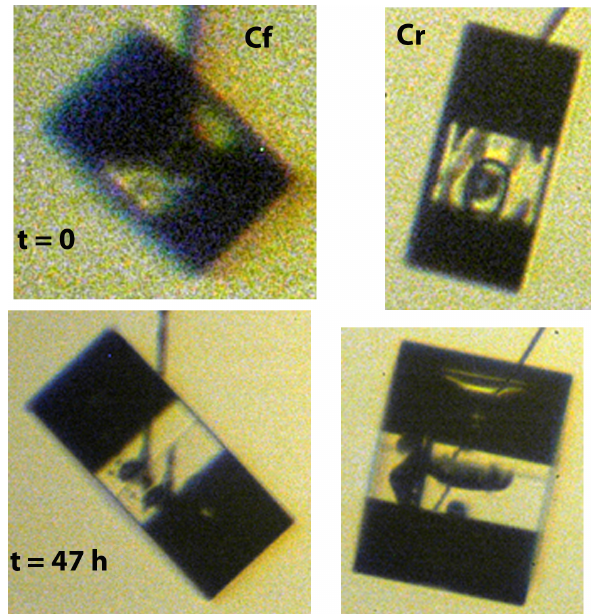
Figure 5. Crystals nucleated from Snomax particles on C f (left) and C r (right), grown simultaneously under the same conditions. The top row images were taken at t = 0, and the bottom row images were taken at t = 47h. Both crystals have a symmetric prismatic hexagonal shape but developed remarkably different aspect ratios. During part B of the experiment the C f crystal decreased in aspect ratio while the C r crystal increased in aspect ratio.